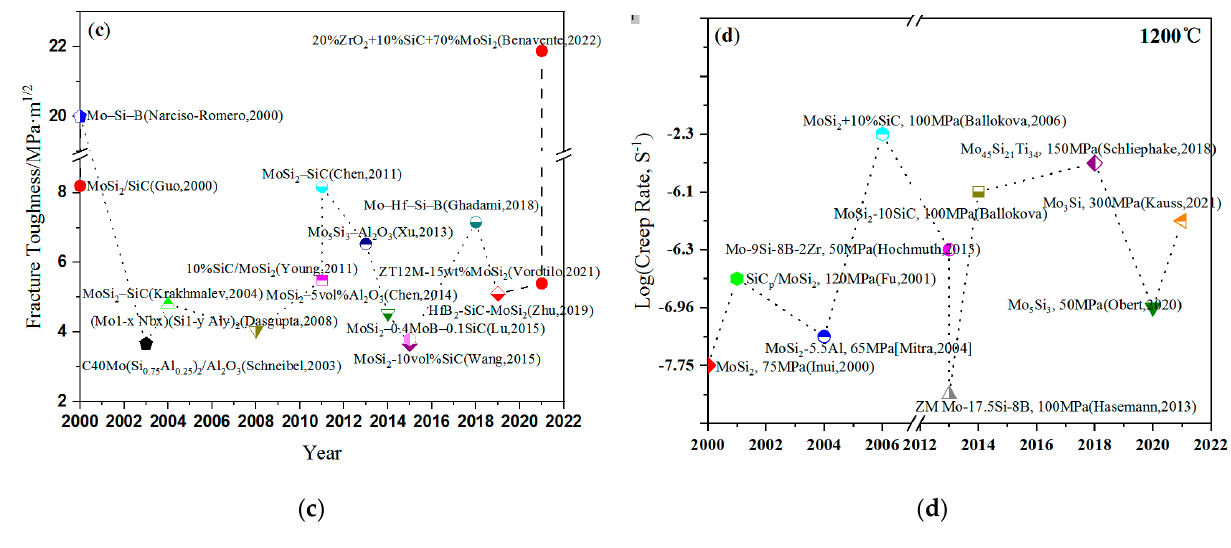
Figure 7. The toughening and strengthening of MoSi 2 matrix composites: ( a ) fracture toughness change of MoSi 2 matrix composites in 1986–2000; ( b ) creep resistance change of MoSi 2 matrix composites in 1986–2000; ( c ) fracture toughness change of MoSi 2 matrix composites in 2000–2021; ( d ) creep resistance change of MoSi 2 matrix composites in 2000–2021 [13,59,60,75–96].